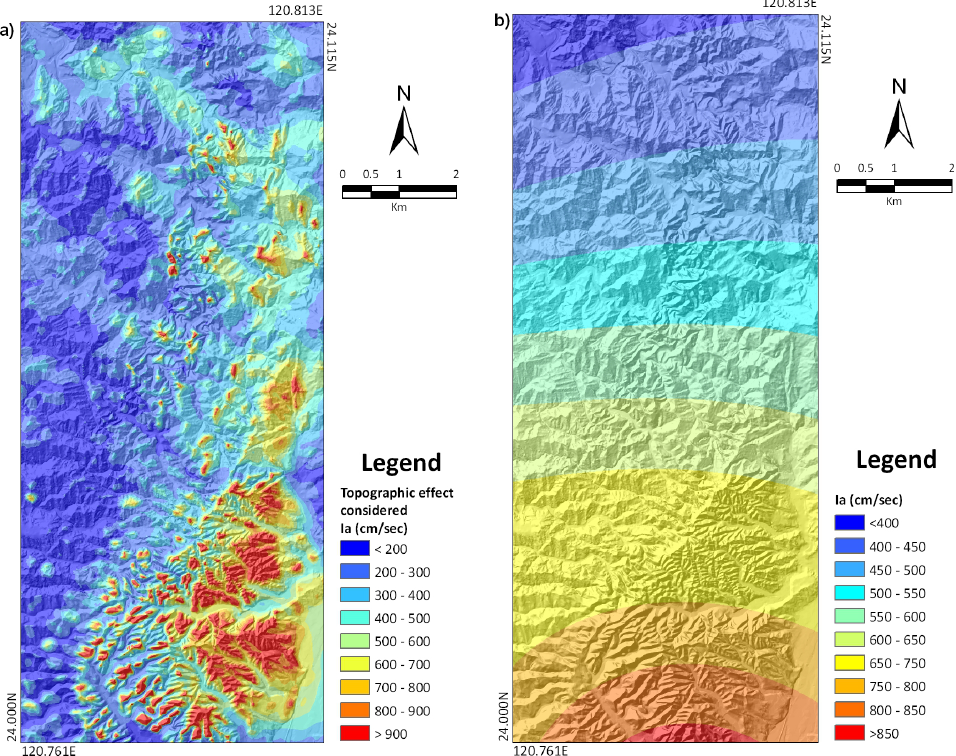
Fig. 9. Arias intensity generated using (a) the proposed procedure with the topographic effect and (b) interpolated from shaking intensity recorded in the seismic